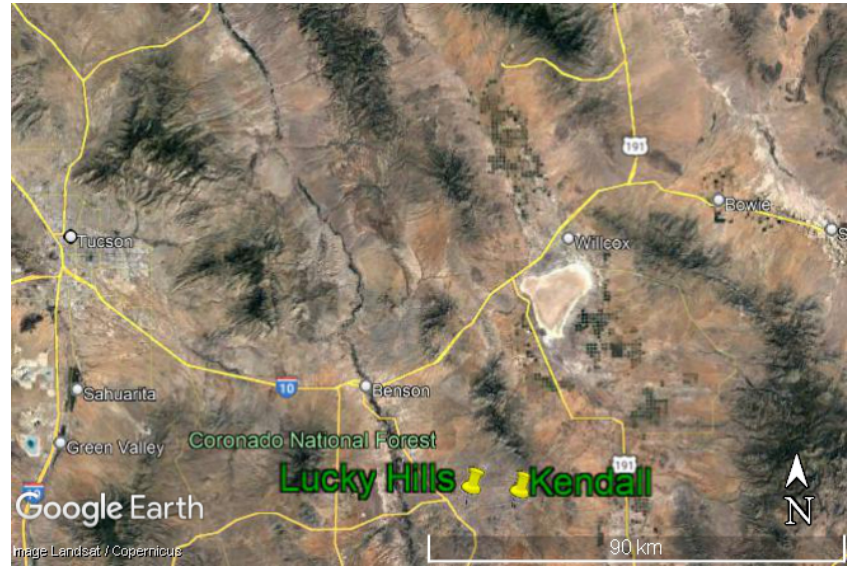
Figure 1. Satellite map of WG SoilSCAPE